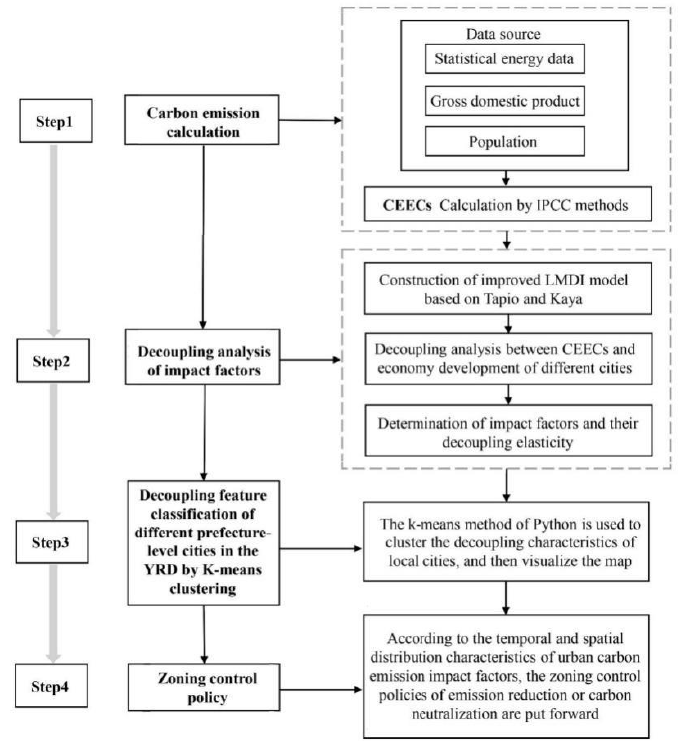
Figure 2. Flowchart of the methodology used in this study. Table 2. Tapio decoupling system.